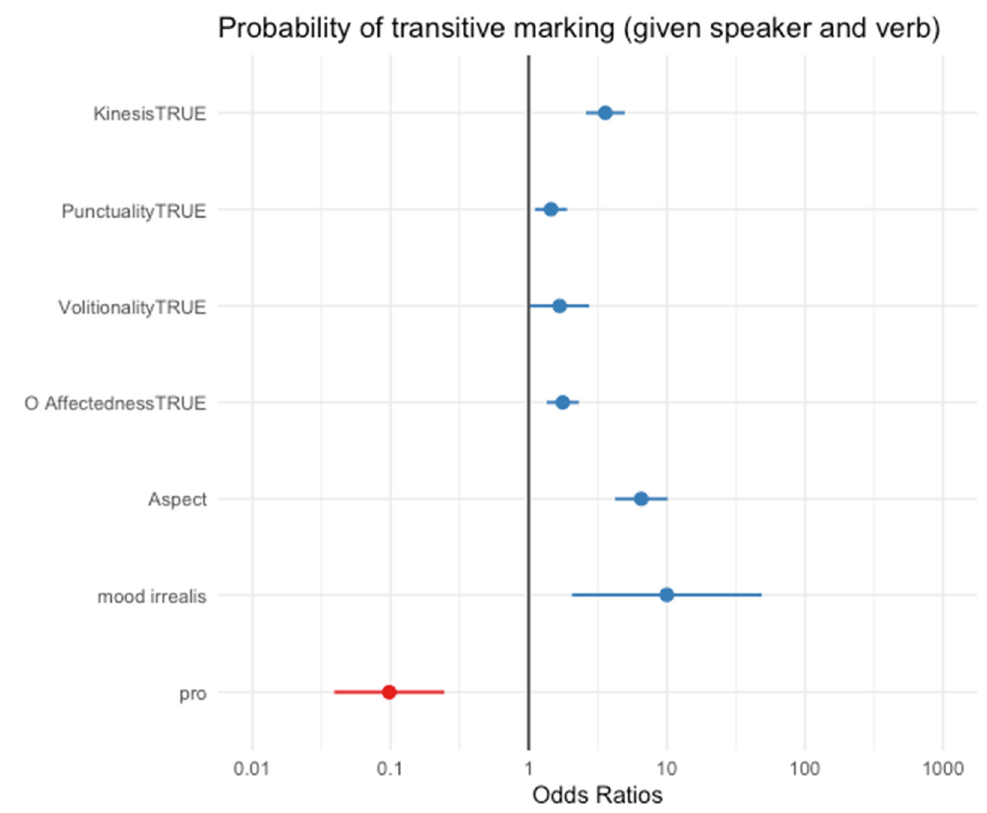
Figure 1. A visualization of the output of the statistical model.